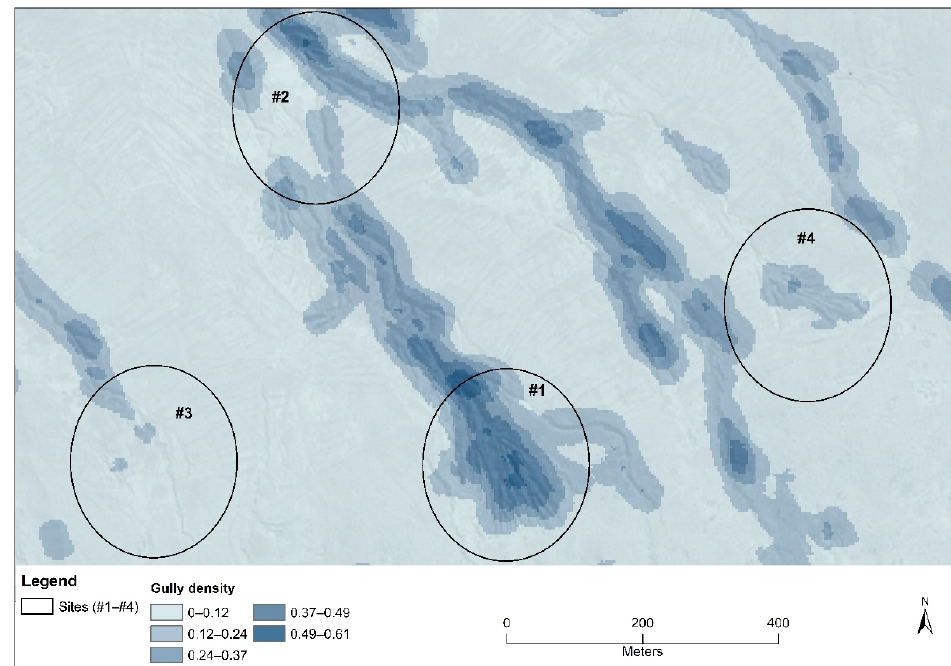
Figure 7. Gully density (m/m 2 ) map of the study